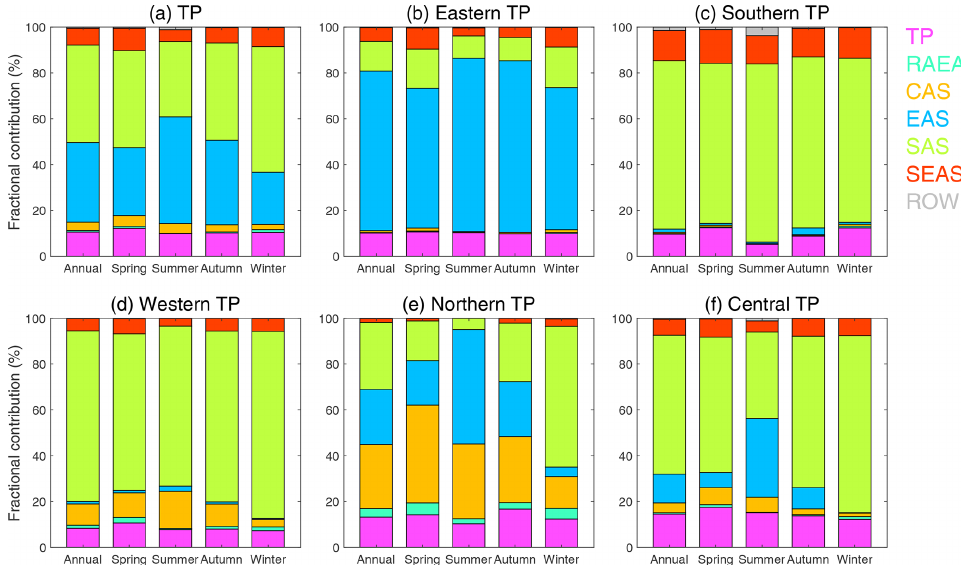
Figure 6. Fractional contributions of different source regions to surface BC over the TP and its subregions. The values are 20-year means (1995–2014) from the CTRL simulation. The abbreviations are for central Asia (CAS); East Asia (EAS); South Asia (SAS); South East Asia (SEAS); the region of the rest of Asia, Europe, and Africa (RAEA); and the rest of the world